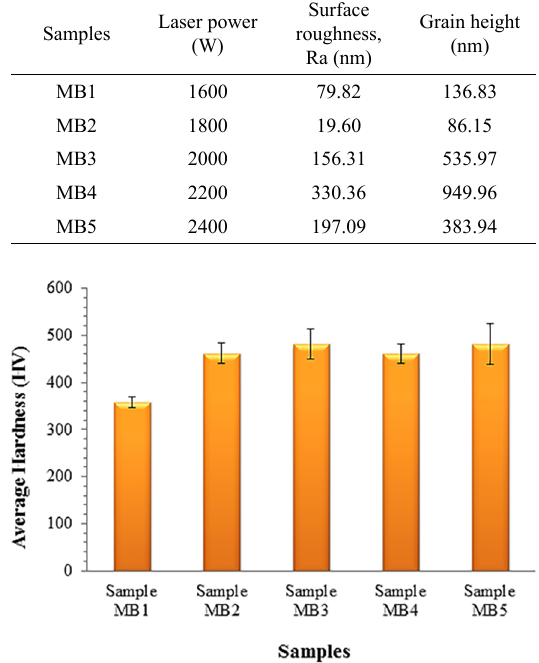
Figure 9. Average microhardness of laser alloyed zone.